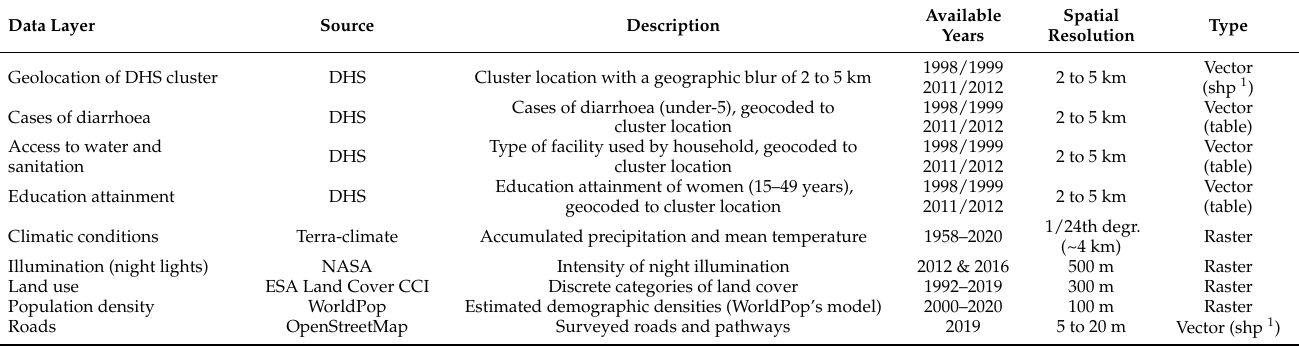
Table 1. List of open-access datasets used to explore relations between landscape and diarrhoea in C ô te